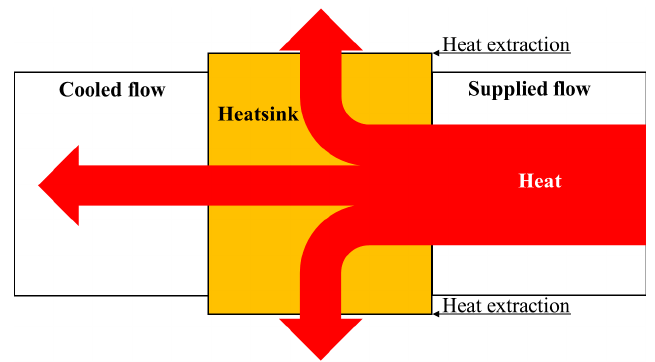
Figure 3. Sketch of the heat sink.